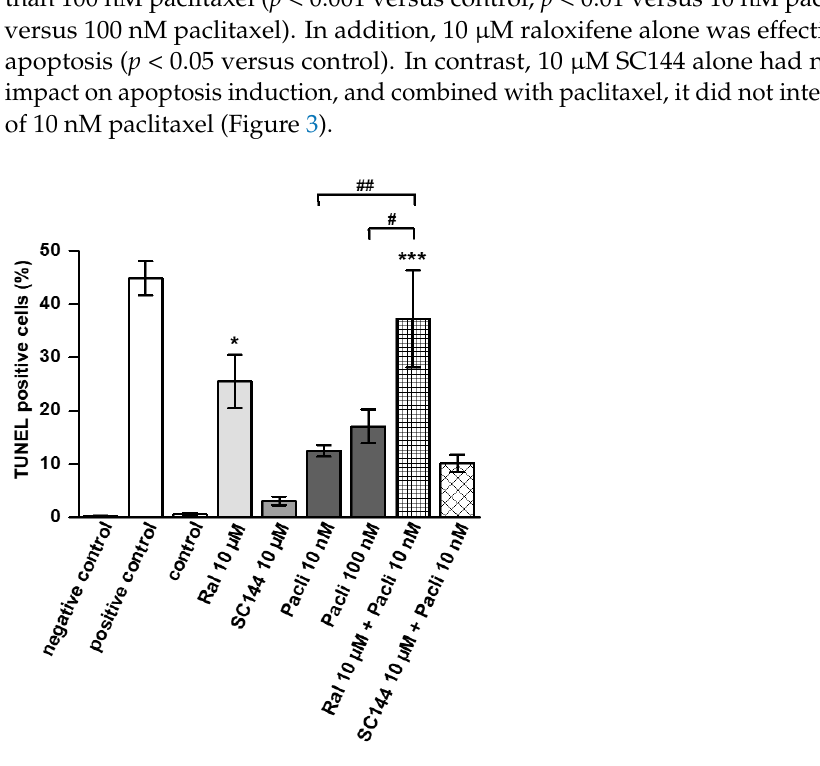
Figure 3. Combined raloxifene/paclitaxel treatment increases apoptosis in L3.6pl cells. TUNEL staining and subsequent FACS analysis were performed on L3.6pl cells treated with different concentrations of raloxifene (Ral), SC144 and paclitaxel (Pacli) alone or in combination. Staurosporine served as positive control, unstained cells served as negative control. The graphs show the mean values ± SEM of n = 4 – 5. * p < 0.05 and *** p < 0.001 versus control; # p < 0.05 and ## p < 0.01 versus paclitaxel.